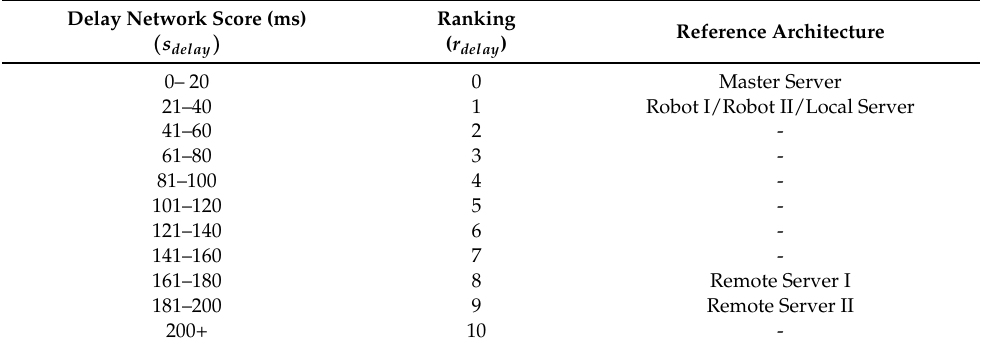
Table 6. Cost of network delay between servers or client-servers. Delay Network Score (ms) ( s delay